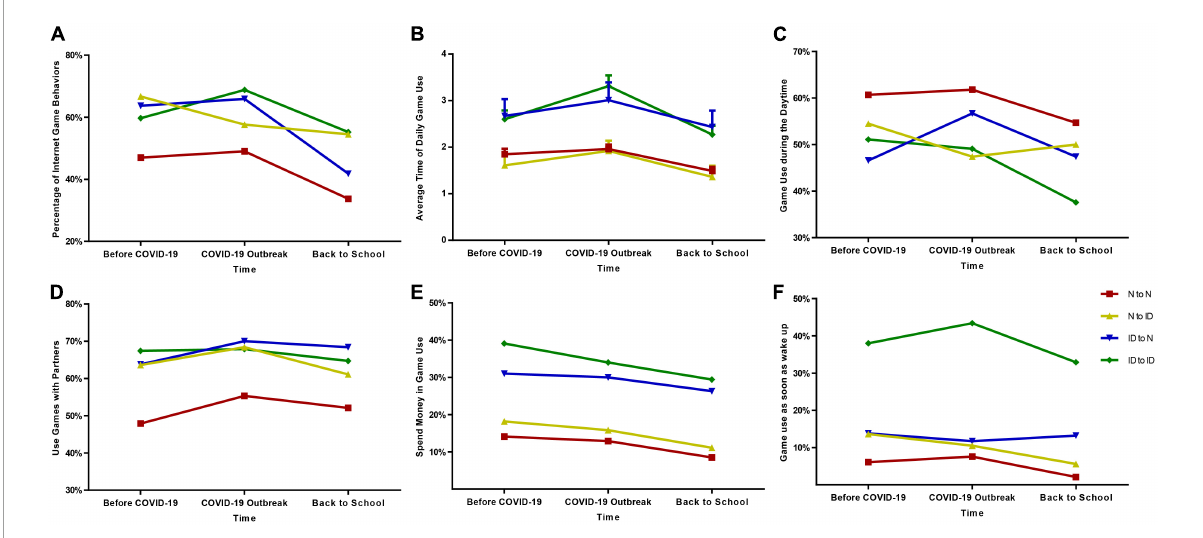
FIGURE2 Changes in game behaviors of adolescents in different Internet behavior changing groups before and after the COVID-19 outbreak. (A) Changes in the percentage of adolescents using games among all adolescents. (B) Changes in the average times of game use of adolescents using games (mean ± SEM). (C) Changes in the percentage of adolescents who use games during the daytimes to all adolescents who use games. (D) Changes in the percentage of adolescents who use games with friends to all adolescents who use games. (E) Changes in the percentage of adolescents who spend money on games to all adolescents who use games. (F) Changes in the percentage of adolescents who use games when they wake up to all adolescents who use games. N to N = Continuous Normal Group; N to ID = From Normal to Internet Addiction Group; ID to N = From Internet Addiction to Normal Group; ID to ID = Continuous Internet Addiction Group. Before COVID-19 (T1) = before Dec 1, 2019; COVID-19 Outbreak (T2) (in China) = Jan 1, 2020 to March 31, 2020; Back to School (T3) (in China) = after April 1,